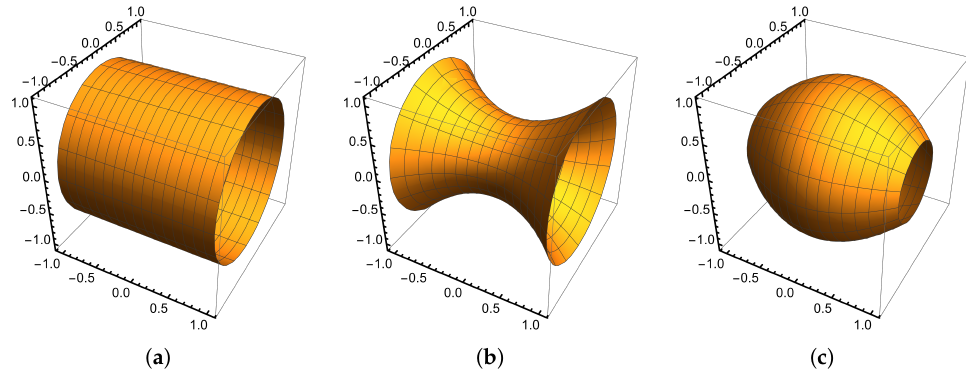
Figure 1. Shell geometries. ( a ) Parabolic. ( b ) Hyperbolic. ( c ) Elliptic. Parabolic (Zero Gaussian curvature shells). One has